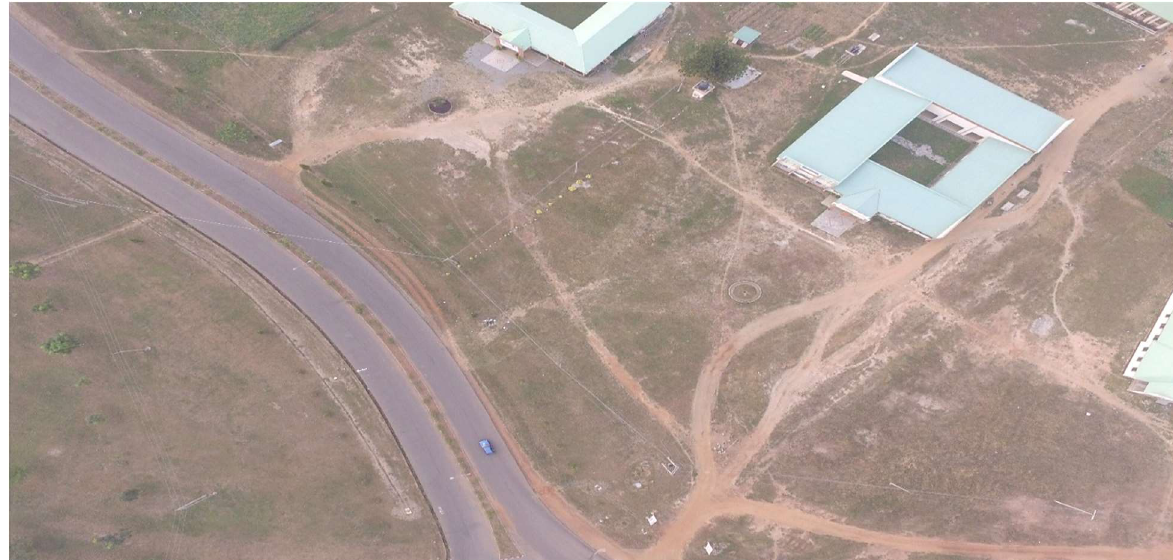
Figure 4a: UAV acquired image of part of FUTMinna, Main Campus (reference image)